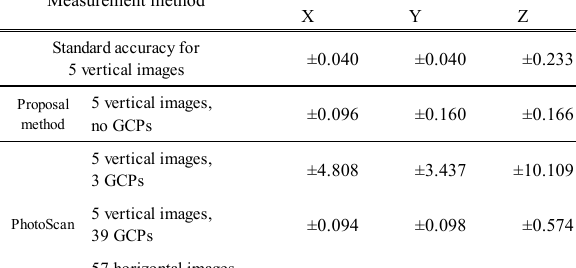
Table 3. Results of checking